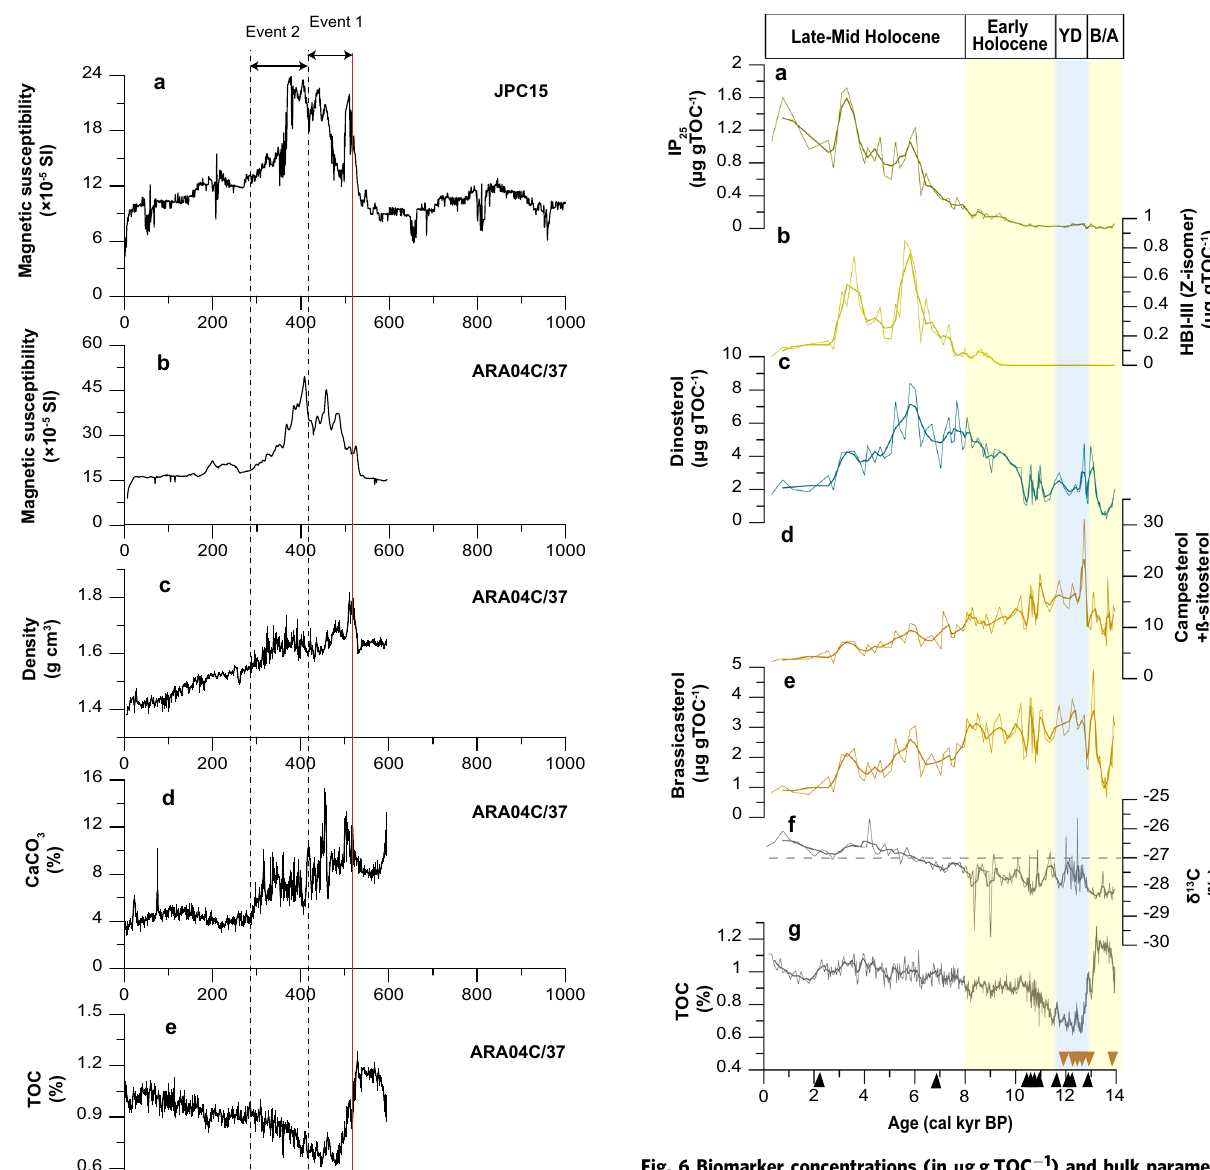
Fig. 6 Biomarker concentrations (in µ g g TOC − 1 ) and bulk parameters. a IP 25 , b HBI-III (Z-isomer), c dinosterol, d terrigenous biomarker (campesterol + ß-sitosterol), e brassicasterol, f δ 13 C values of TOC ( ‰ ), g TOC content (%). Triangles refer to AMS 14 C dates used in the age – depth model (see Fig. brassicasterol in our record has a mixed source from freshwater and marine algae. During the last deglaciation and the early Holocene (~14 – 8 kyr δ 13 C − 28 to − 27 ‰ (Fig. 6f), BP ), very negative org values of relatively high terrigenous biomarker accumulation rates of 5 – 20 µg cm − 2 kyr − 1 (Fig. 7f), and high F C32 1,15 values up to 0.5 (Fig. 7g) all point to high terrigenous input. Relatively warm and wet environments promoted terrigenous matter transport, and low sea-level conditions resulted in a closer distance of the core site to the river mouth receiving more terrigenous matter. In the mid-late Holocene (8 – 0 kyr BP ), δ 13 C org values increased (> − 27 ‰ ) and terrigenous biomarker accumulation rates decreased to 1 µg cm − 2 kyr − 1 (Figs. 6f and 7f). Similarly, F C32 1,15 values decreased to 0.3 (Fig. 7g), re fl ecting a descending river discharge and an increasing distance of the core site to the river mouth (cf. Ref. 56 ).